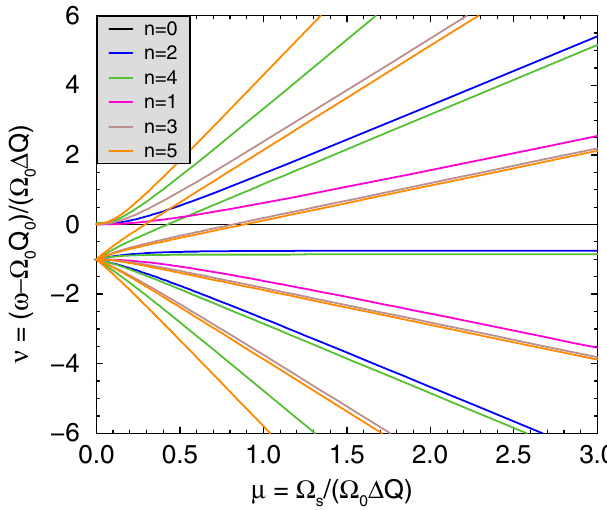
FIG. 1. (Color) Exact eigenvalues of the boxcar